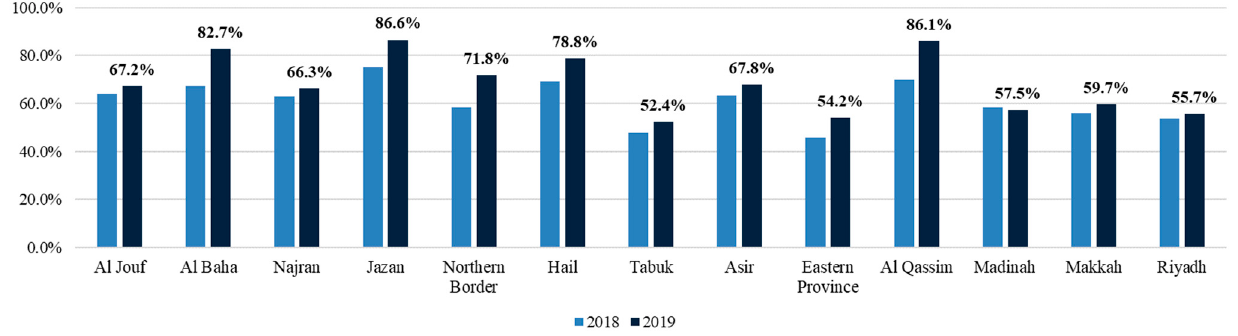
Figure 2. The Growth of the Number of Housing Units in Various Regions of Saudi Arabia.